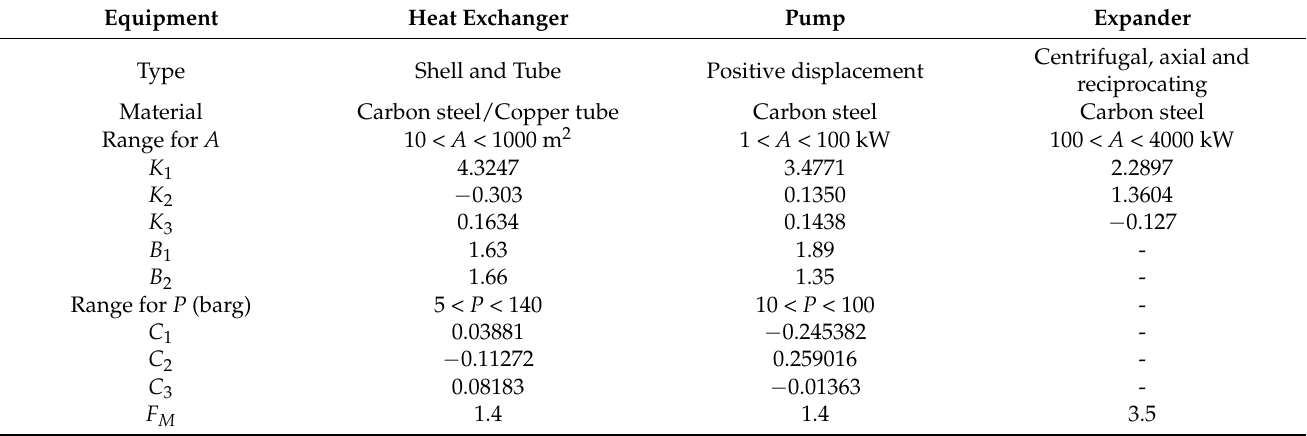
Table 11. Costing factors used for ORC